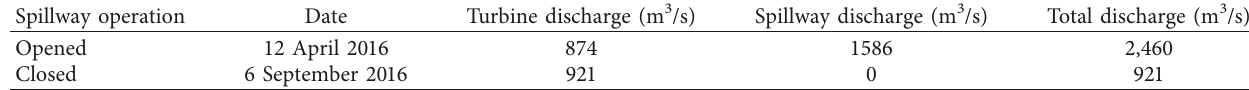
Table 2: Discharge from turbines and spillways during opened and closed spillways on the two sampling dates. Spillway